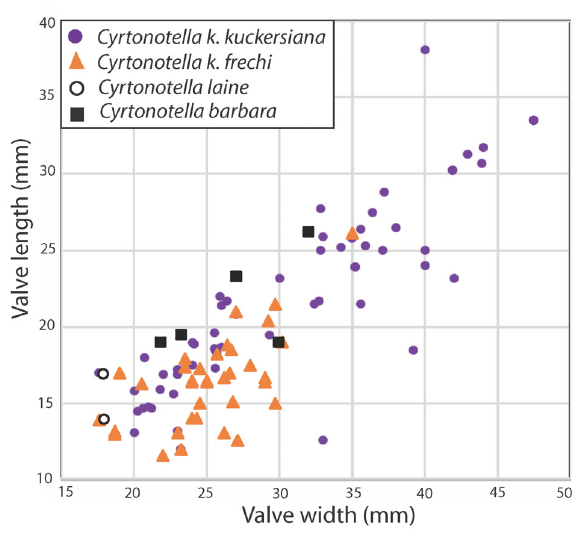
Fig. 3. Measurements of 105 dorsal valves of the species of